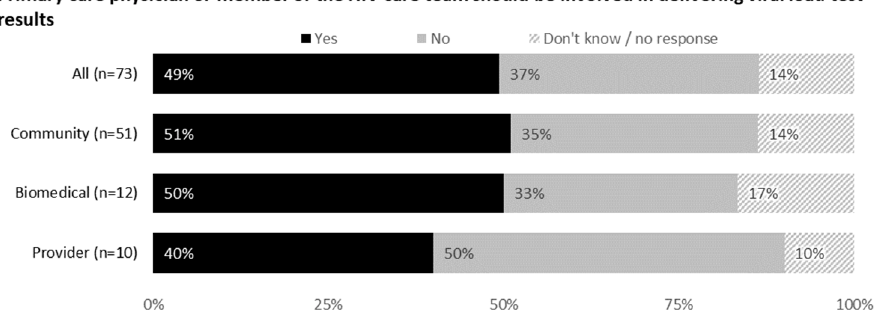
Figure 4. Feedback on communicating viral load test results from all participants (United States, 2021).